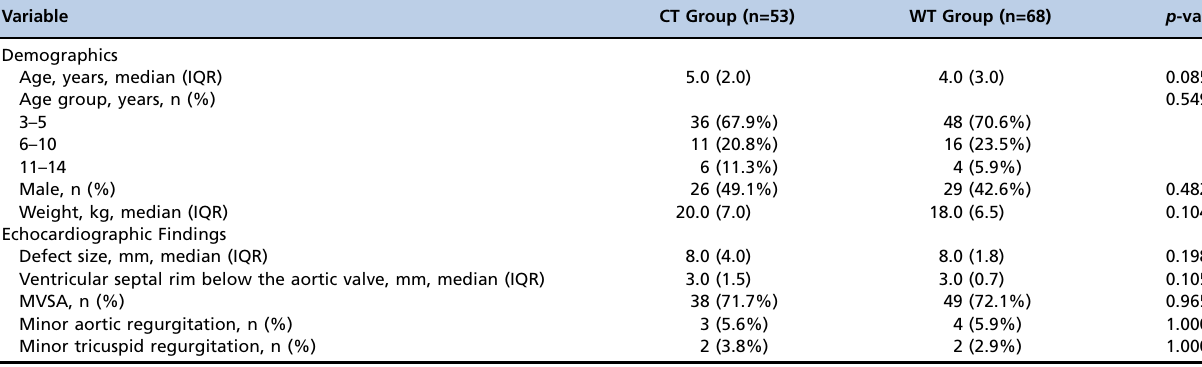
Table 1 - Baseline Characteristics of the Two